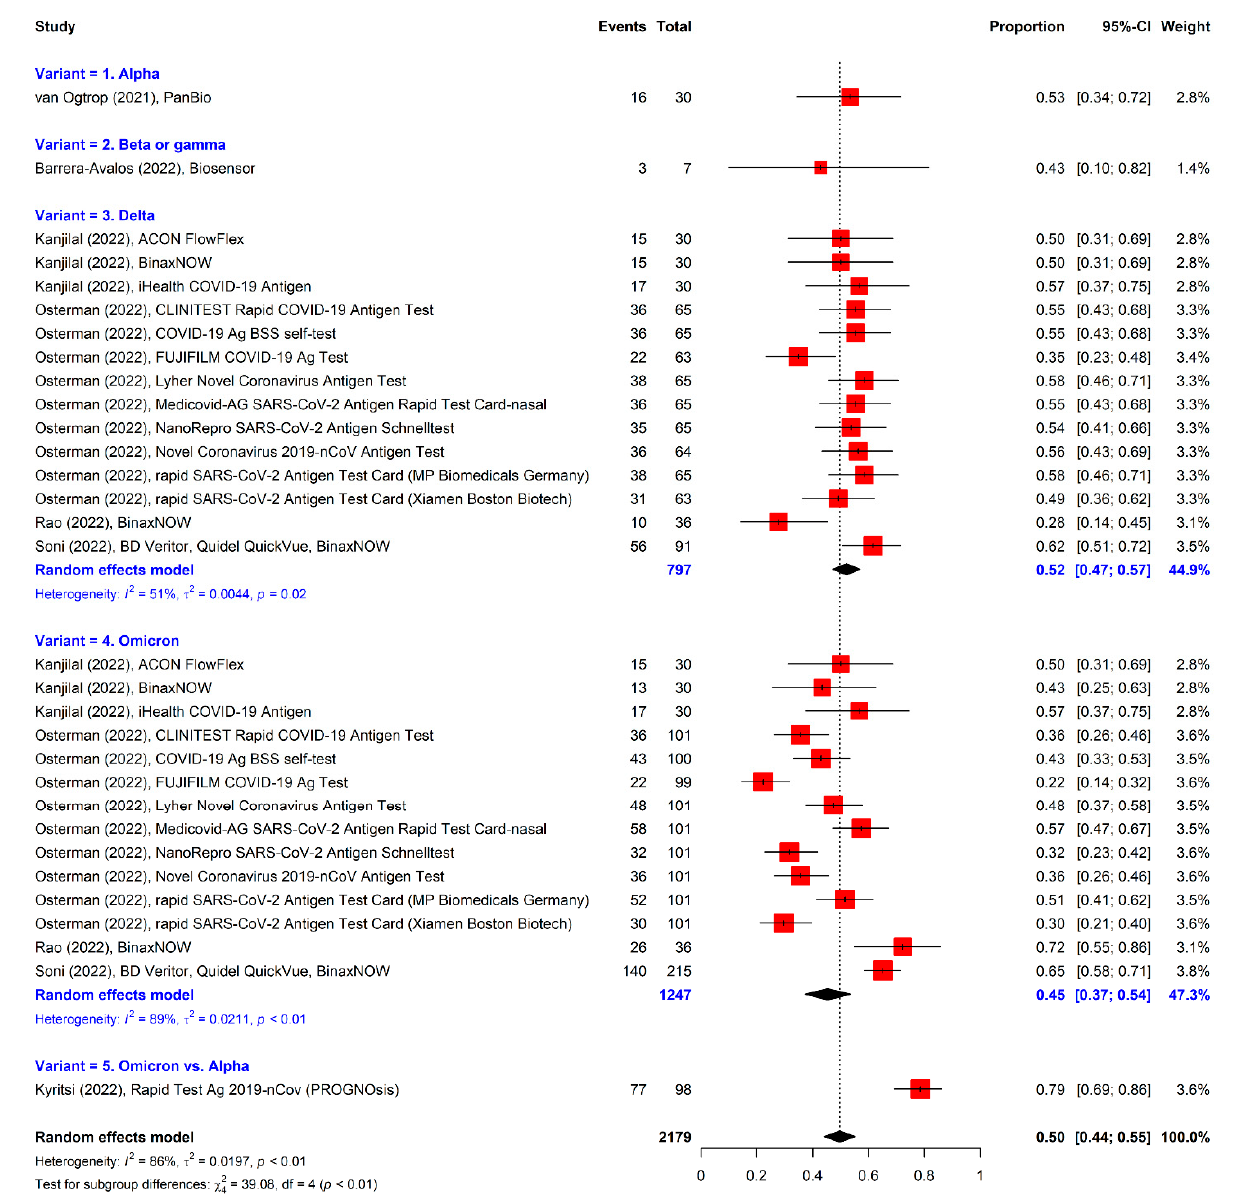
Figure 8. Forest plot using univariate analysis only for the sensitivity of